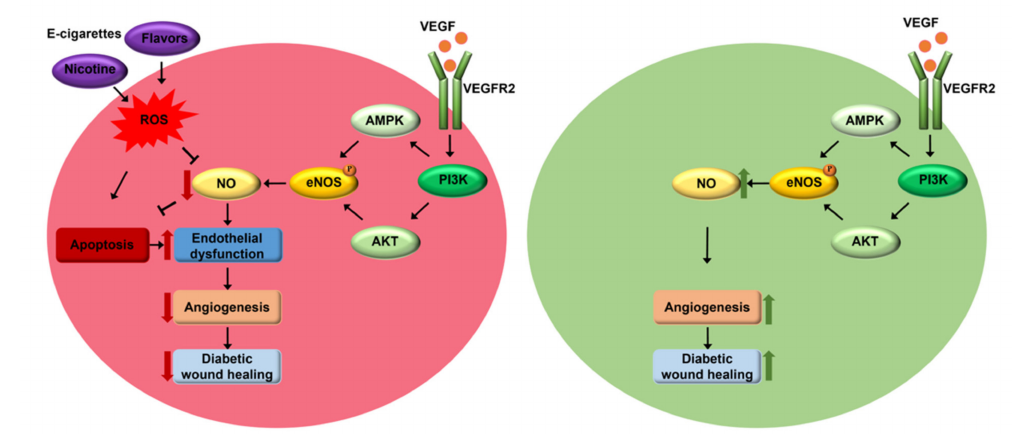
Figure 6. Molecular mechanisms underlying e-cigarette induced impairment in angiogenesis and di- abetic wound healing. Under normal conditions, vascular endothelial growth factor (VEGF) activates PI3K dependent eNOS phosphorylation via AKT and AMPK to result in elevated NO production to mediate enhanced angiogenesis and improved diabetic wound healing. Exposure to nicotine- containing or flavored e-cigarettes results in increased reactive oxygen species (ROS) production, reduced NO bioavailability and endothelial cell apoptosis, leading to endothelial dysfunction and consequent deficiencies in angiogenesis and diabetic wound